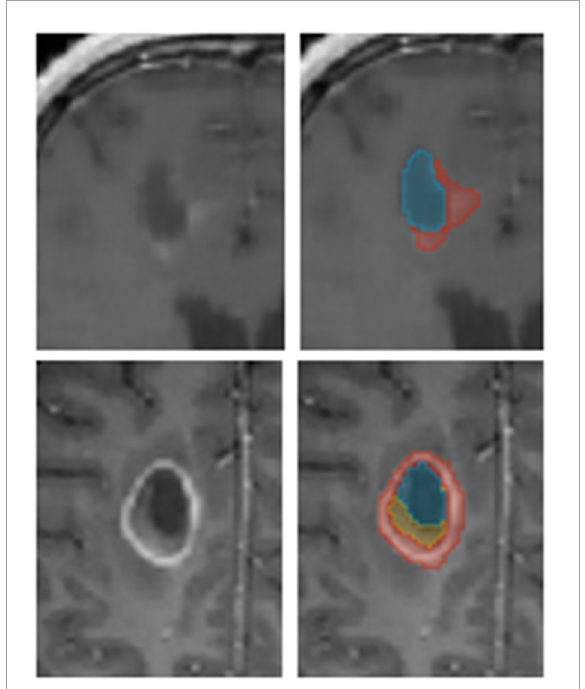
FIGURE1 An example of annotated data. The glioblastoma multiforme (GBM) tumor as observed on MR T1 gad images (Left) along with annotators’ segmentation (Right) . Enhancing tissue (red), necrotic core (yellow), and resection cavity (blue) are segmented for Tumor Treating Fields (TTFields) treatment